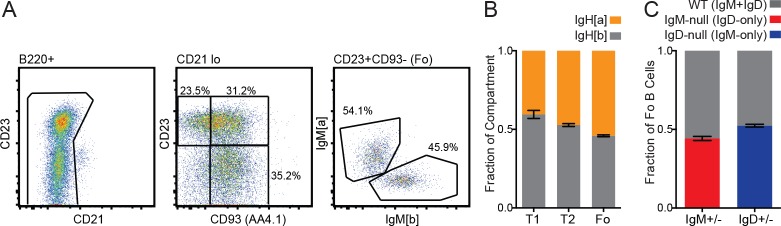
Splenic B cell subsets in IgHa/b, IgM+/−, and IgD+/− Lyn−/− mice.(A) Gating scheme for determining Ig locus of origin for splenic B cell subsets in 6-month-old IgHa/b Lyn−/− mice. (B) Quantification of compartments in (A). T1 (CD93+CD23-); T2/3 (CD93+CD23+); Fo (CD93-CD23+). (C) Percentage of Fo B cells originating from each Ig locus in IgM+/− and IgD+/− mice on the Lyn−/− background. Percentages in (A-C) were calculated using n = 5–6 mice of each genotype, and mean +SEM is displayed.